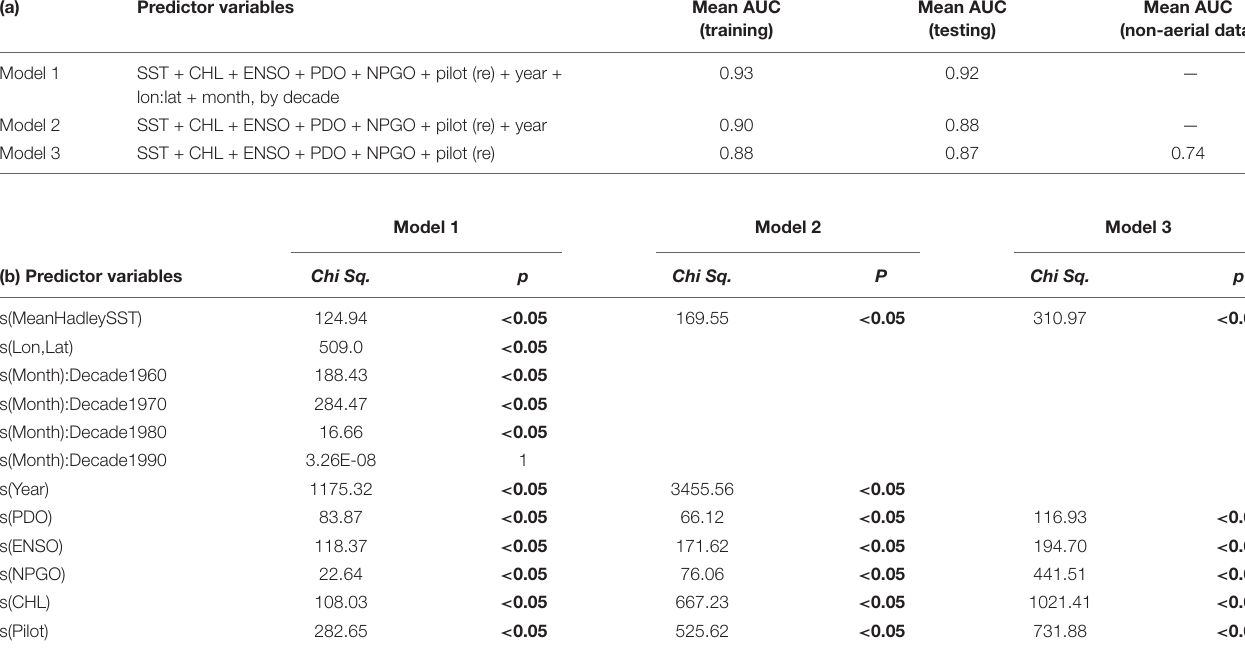
TABLE 1 | (a) Summary table of general additive mixed models [GAMMs] used in testing and training. (b) Output summary of GAMMs, including p -values and chi-square values. Summaries represent an example from one round of testing and training; outputs from all five rounds were similar.